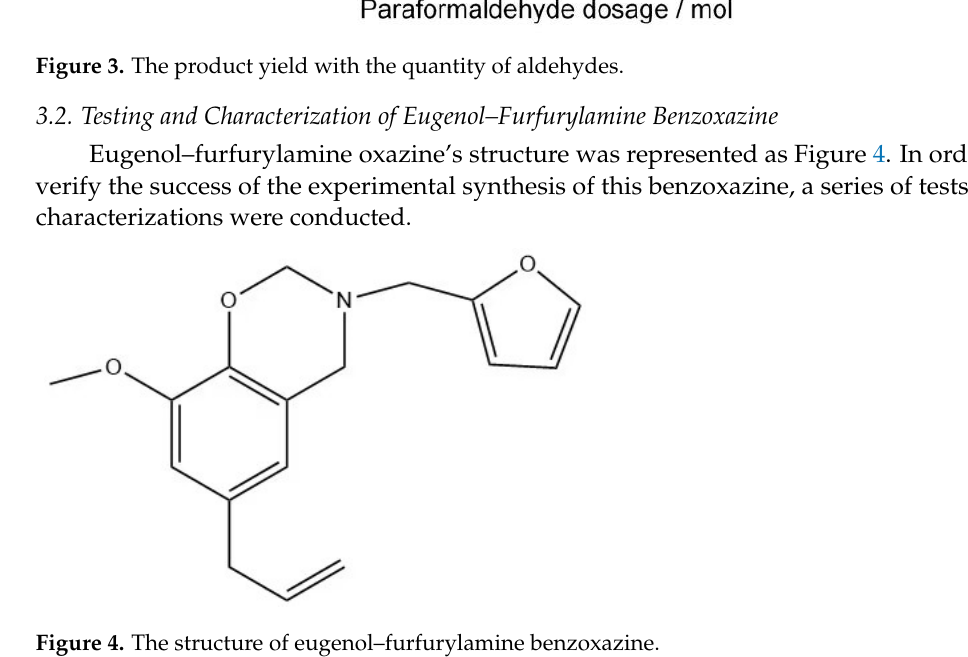
Figure 3. The product yield with the quantity of aldehydes.